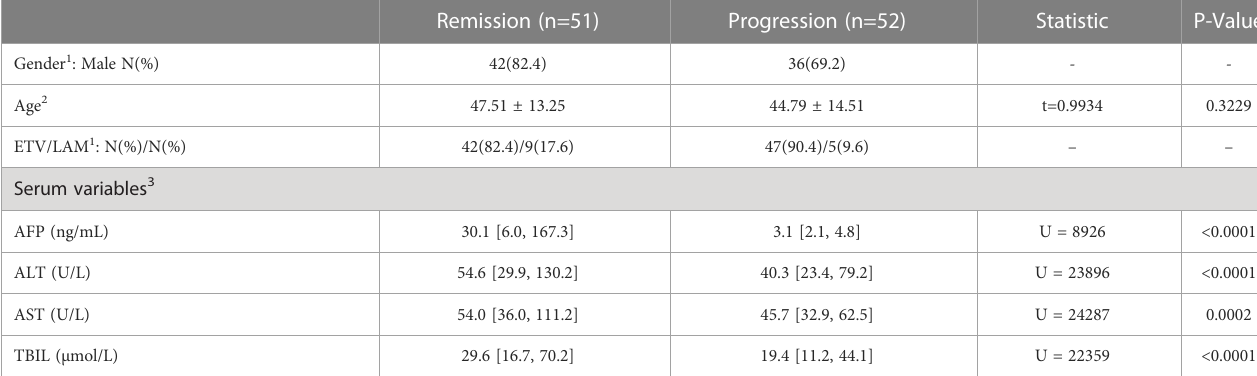
TABLE 1 Patients ’ information and laboratory test results on the date of initial